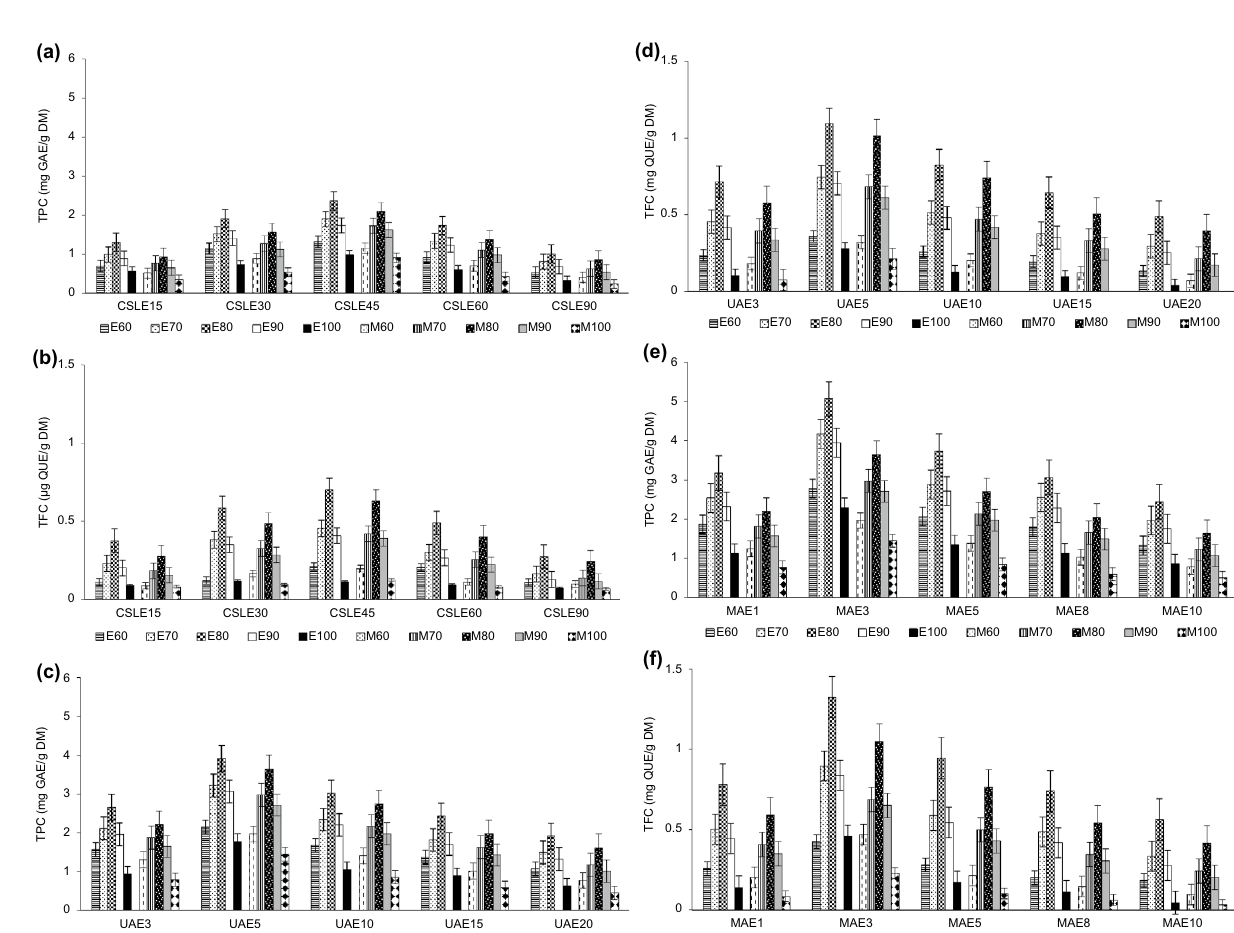
Figure 1. TPC and TFC in distillery stillage extracts obtained with CSLE ( a , b ), UAE ( c , d ), and MAE ( e , f ) for varying extraction